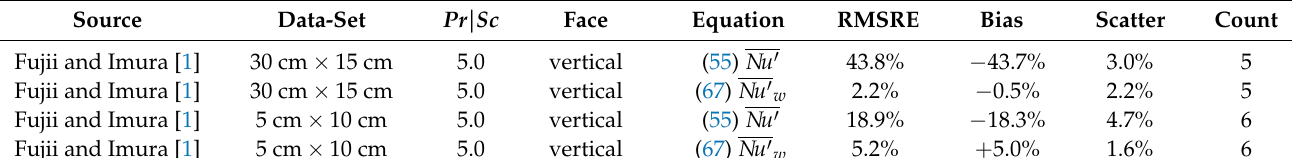
Table 9. Vertical Fujii and Imura plates.